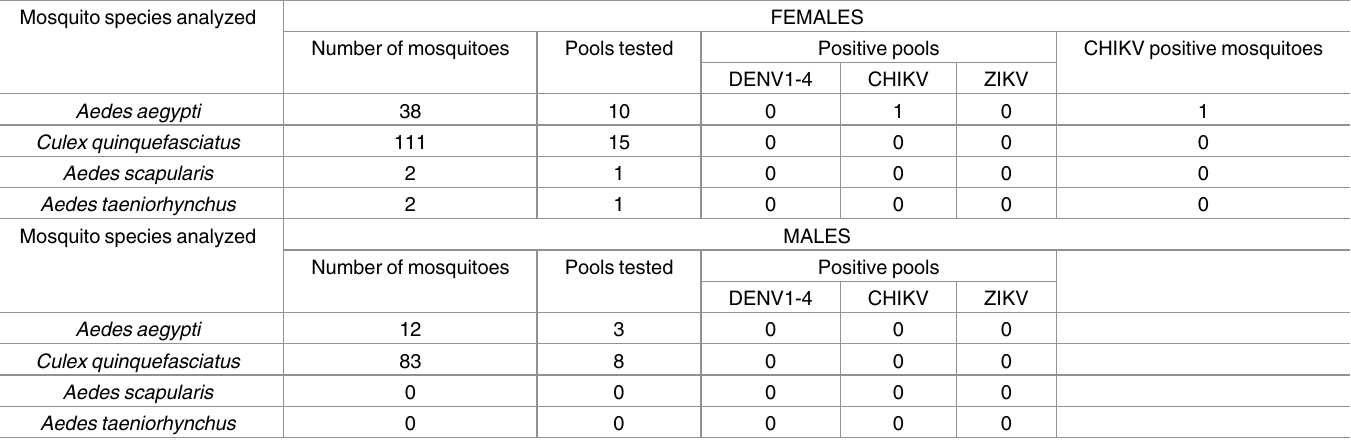
Table 2. Collected species and results of one step qRT-PCR diagnostics for Dengue, Chikungunya and Zika viruses. Mosquito species analyzed